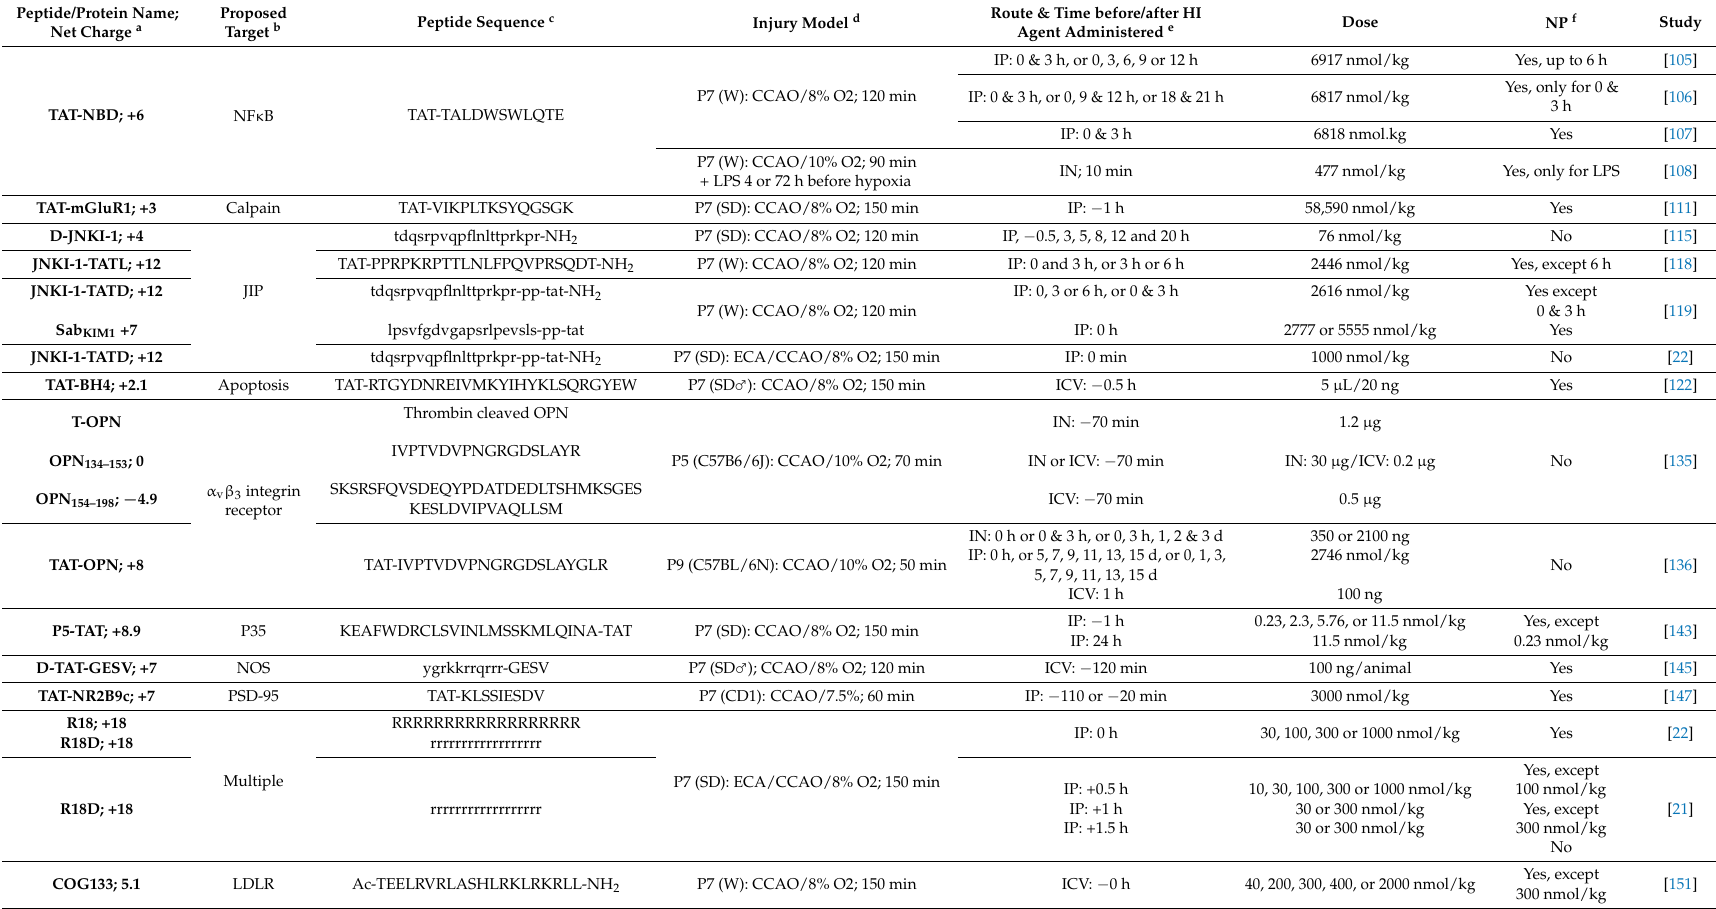
Table 1. Studies using CARPs and other peptides examined in animal models of